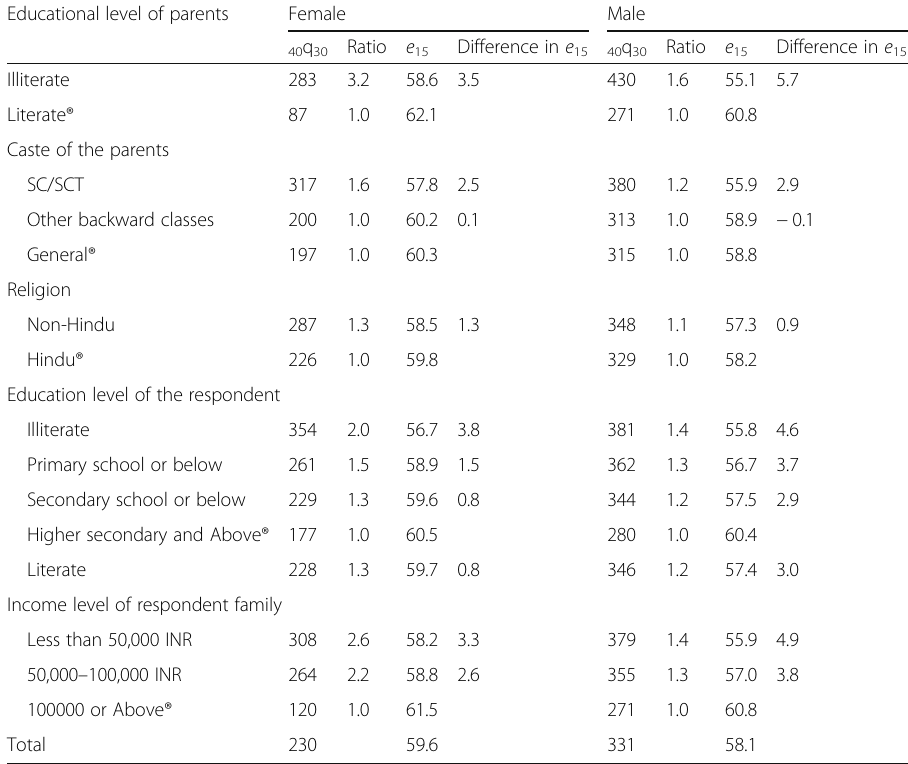
Table 4 Male and female 40 q 30 (per 1000 adults) and ( e 15 ) by socioeconomic status, 1998 – 1999,